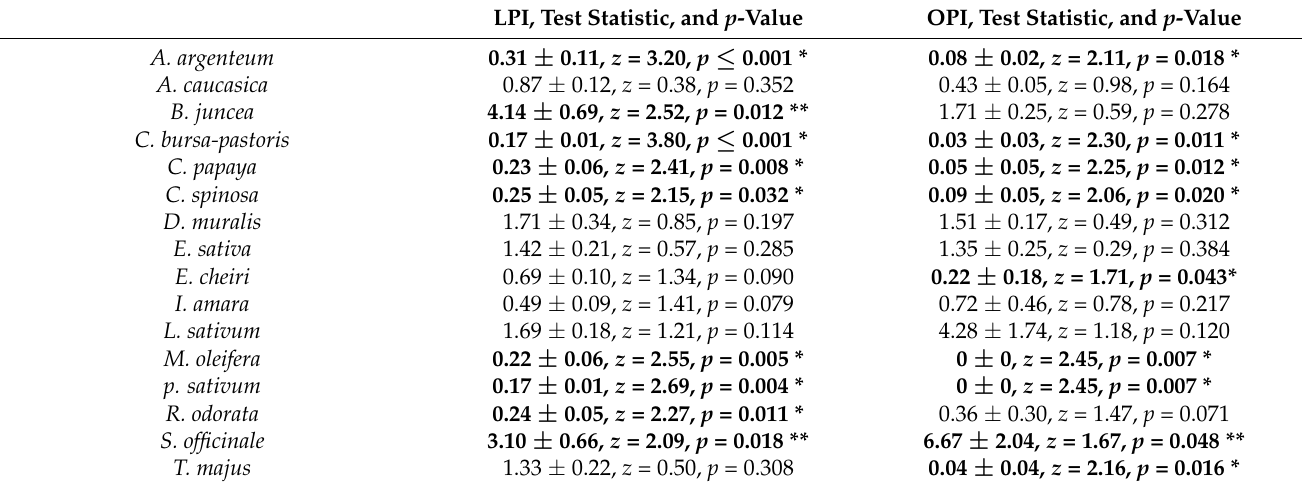
Table 4. Two-choice larval preference index (LPI) given as mean ± SE in larvae of P. xylostella (DBM- C). Data were analyzed using a one-tailed, two-sample test of proportions comparing the relative percentages of choices made between A. thaliana ( p ≤ 0.05) (n = 4–8). Significant differences are shown in bold type. Oviposition preference index (OPI) values taken from Badenes-P é rez et al. [10]. LPI, Test Statistic, and p -Value OPI, Test Statistic, and p -Value